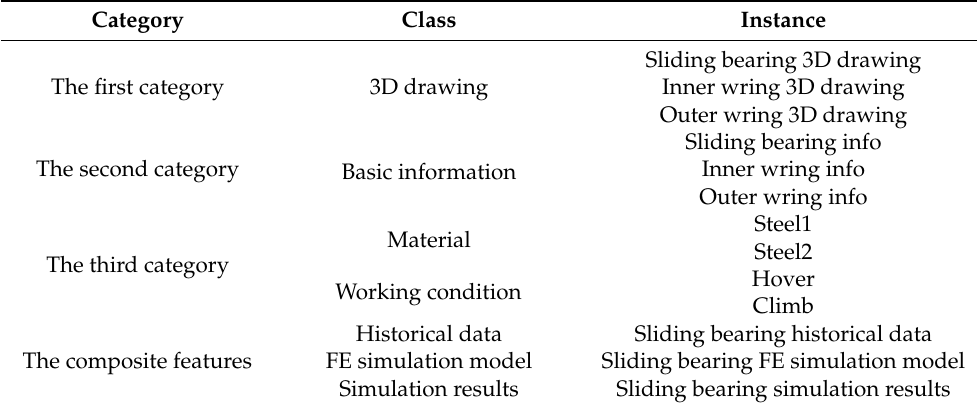
Table 4. Product feature classification